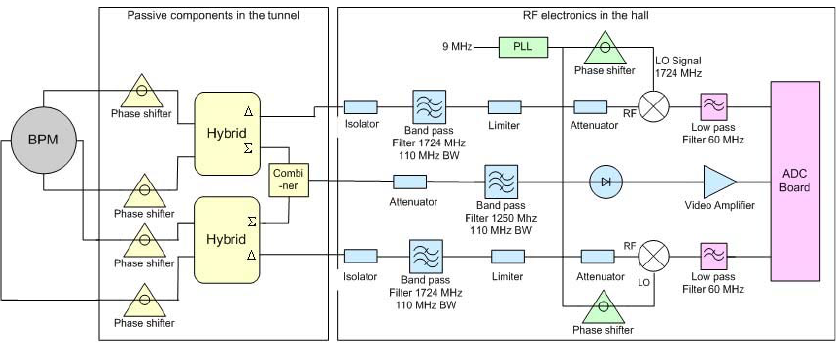
FIG. 11. (Color) The rf signal processing